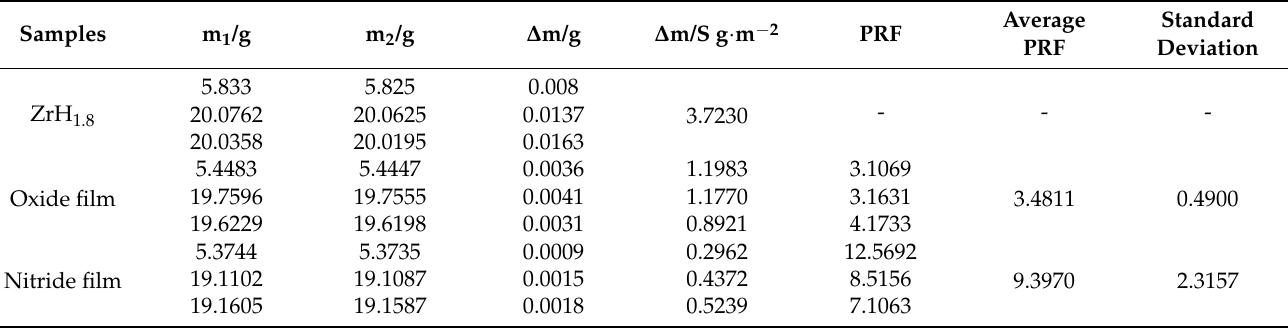
Table 5. PRF values of zirconium hydride samples with different